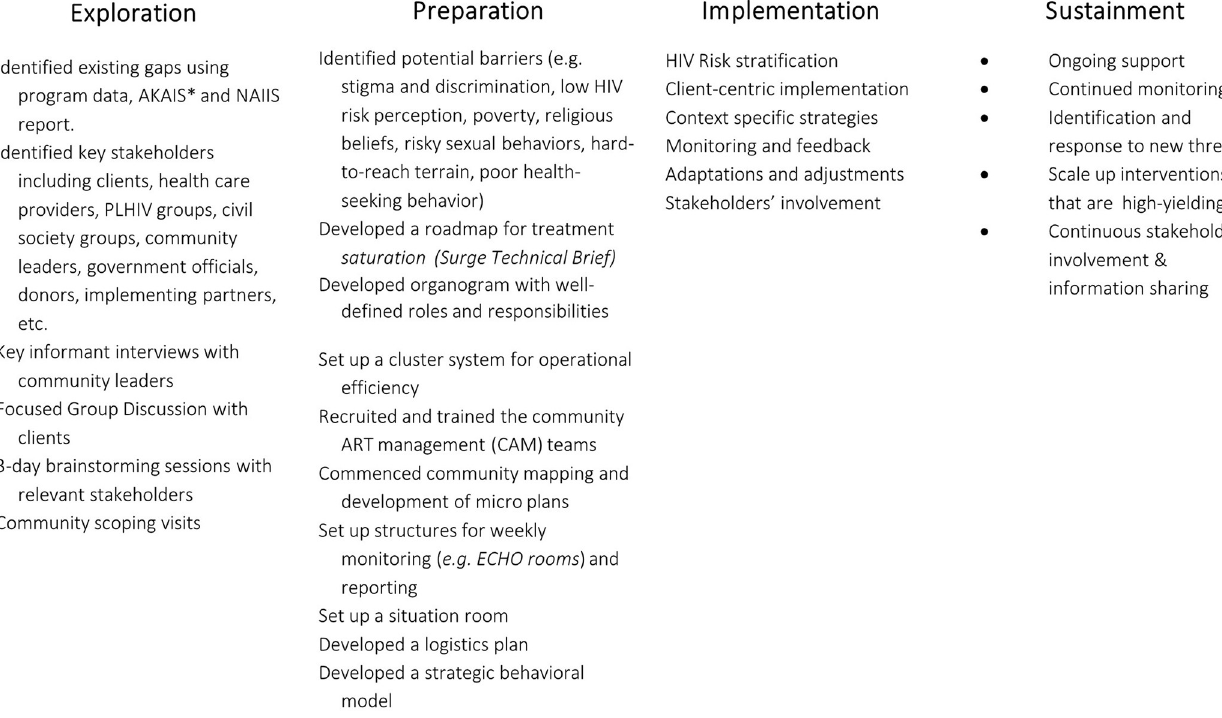
PLOS ONE | https://doi.org/10.1371/journal.pone.0278946 December21,